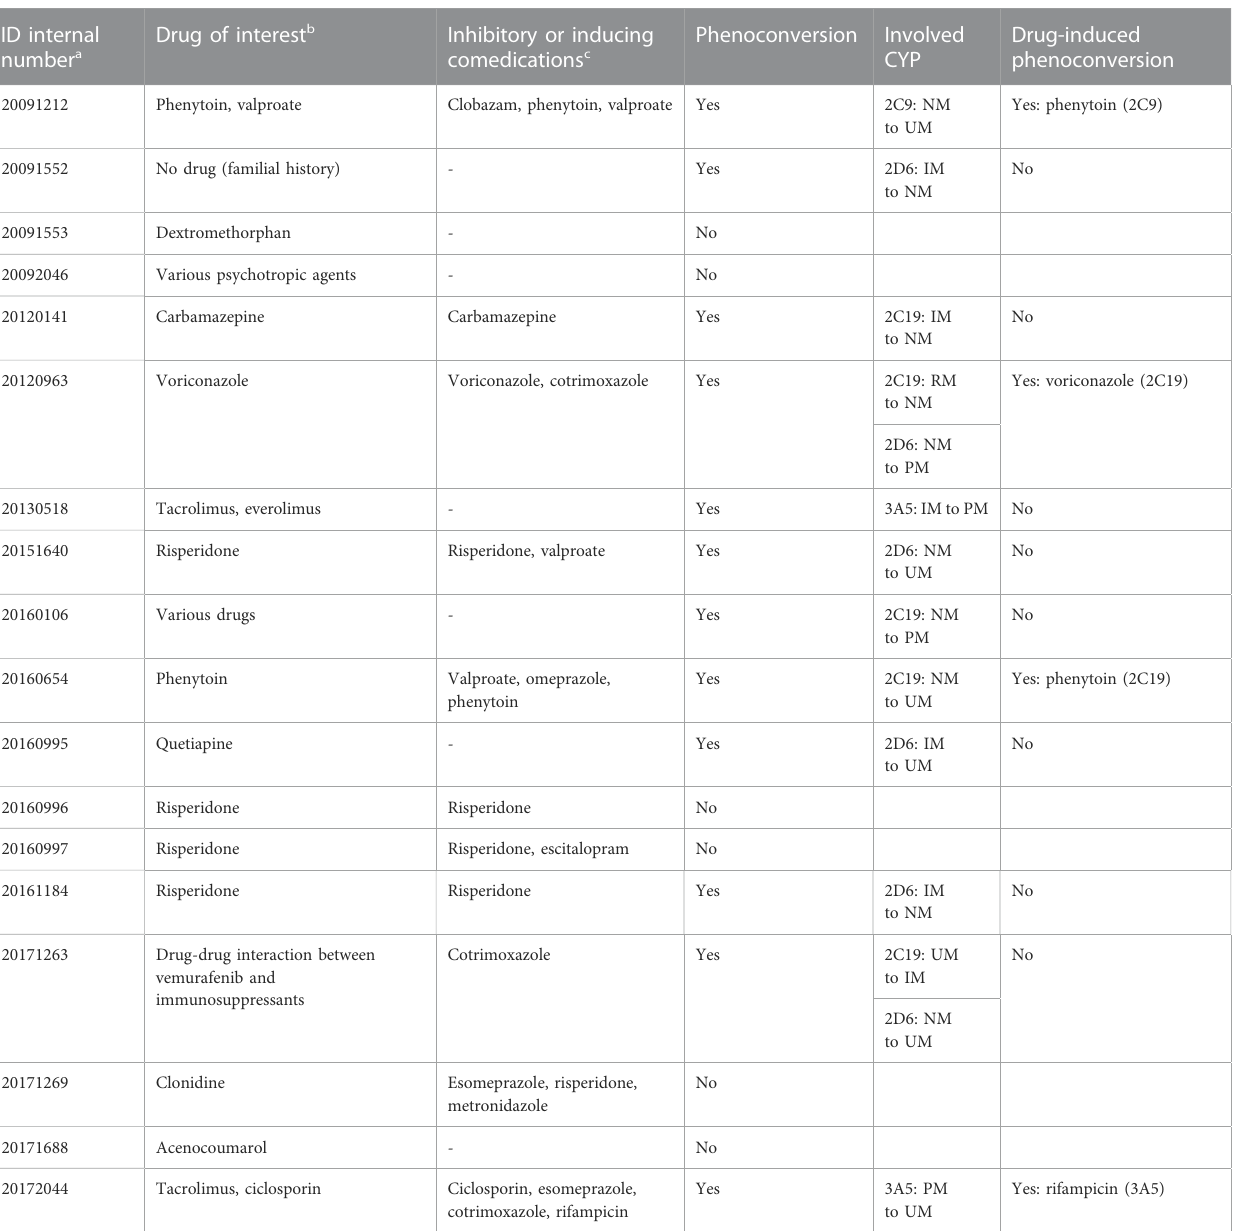
TABLE 3 Comedication in patients undergoing concomitant genotyping and phenotyping. ID internal Drug of interest number a